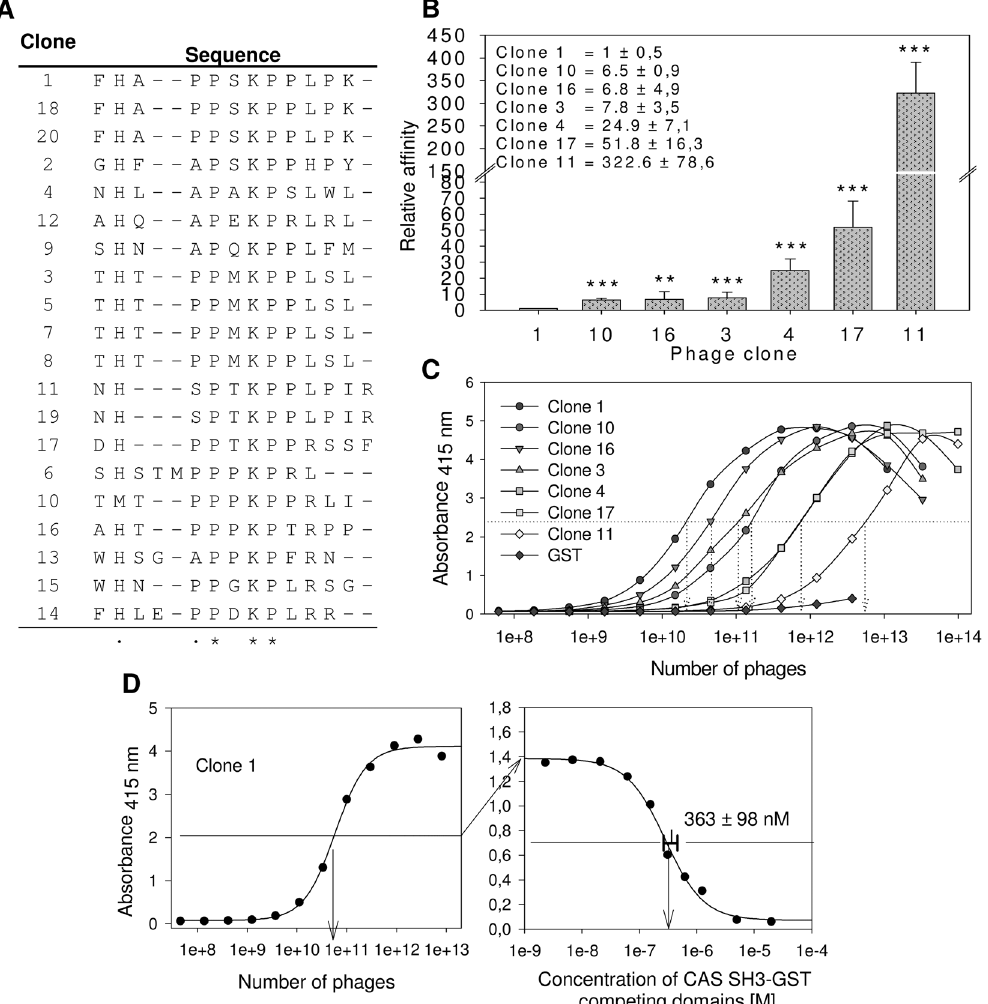
Figure 2. Screening of the CAS SH3 domain binding motif using phage display. ( A ) Sequences of 20 aligned clones. ( B ) ELISA quantification of the relative affinities of seven phage-displayed peptides towards the GST- fused CAS SH3 domain. Relative affinities were calculated based on the binding affinity of clone 1 (the tightest binder). The data are expressed as average ± standard deviation from five independent experiments. Statistical significance ( ** p < 0.01, *** p < 0.001) was determined on log-transformed data by one-way repeated-measures ANOVA followed by Tukey’s post-hoc test. ( C ) Representative curves of relative affinities of seven phage- displayed peptides towards the GST-fused CAS SH3 domain. GST alone with clone 1 was used as a negative control. D Representative graph for the EC 50 value (363 + / − 98 nM) for clone 1 binding obtained from seven independent